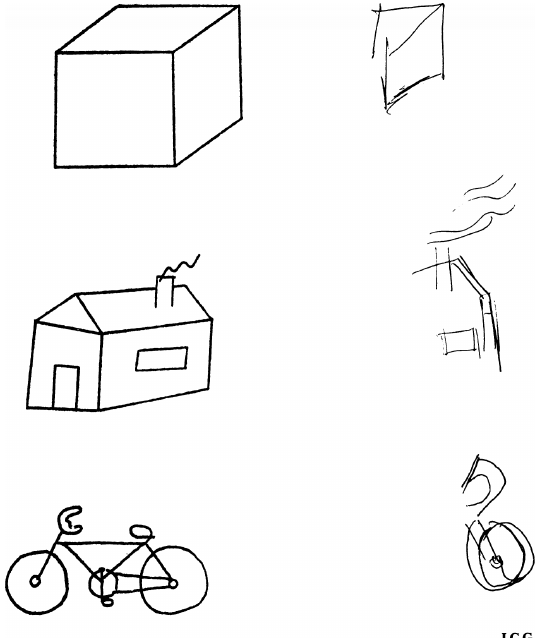
Fig. 1. Examples of drawings performed by J.C.G. in copying: a cube, a house and a